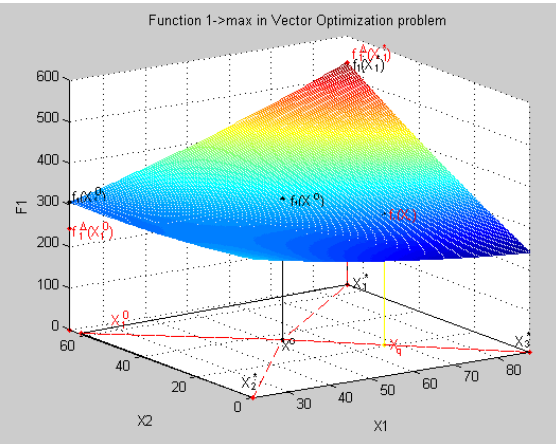
Figure 16. The first characteristic f 1 (X) of the system in a natural indicator.